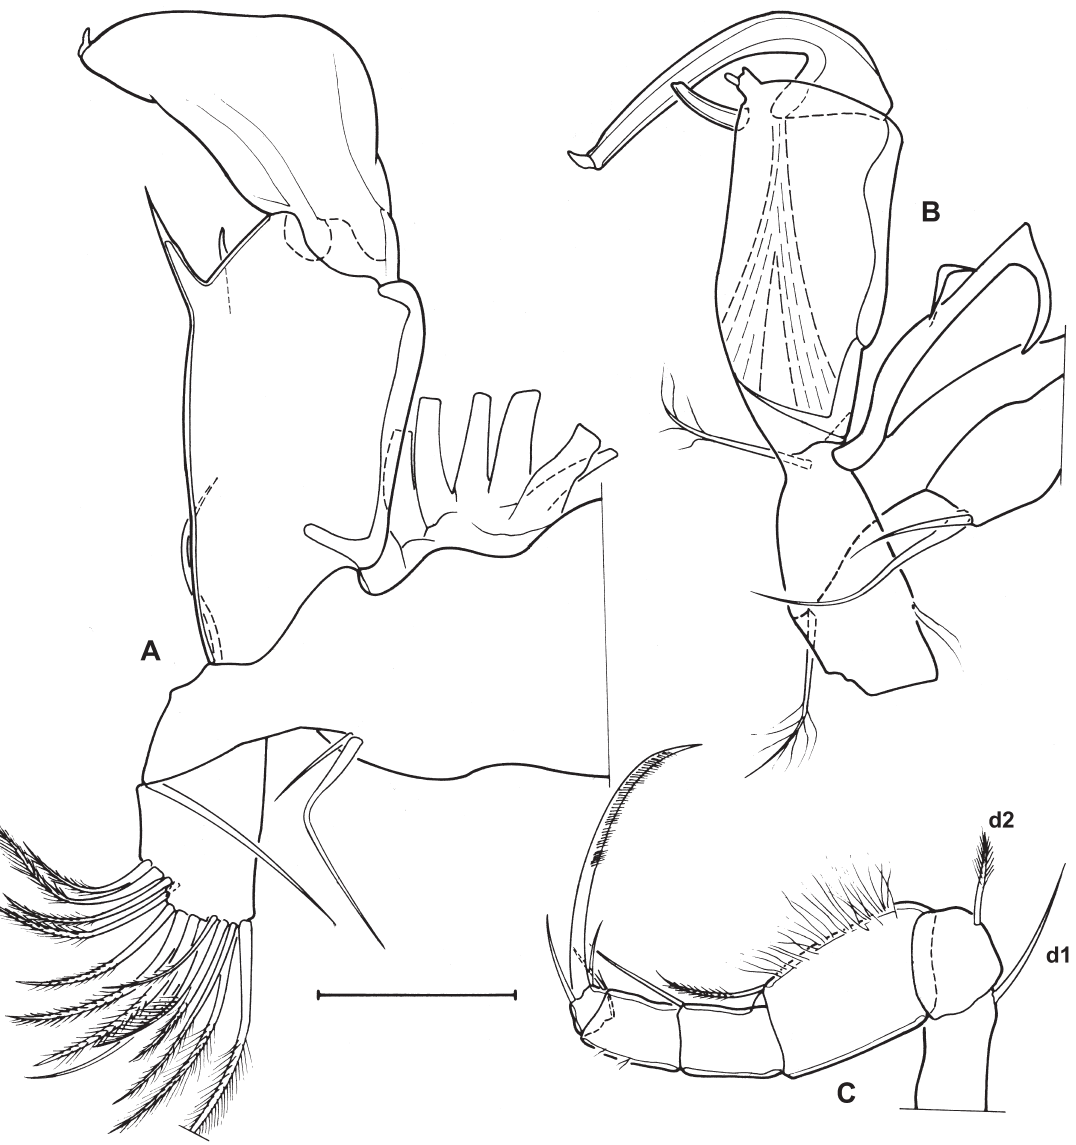
Fig. 13. Bennelongia coondinerensis sp. nov. ♂. A . T1, showing right prehensile palp (holotype ♂, WAM.C49389). B . Left prehensile palp (Idem). C . T2 (OC.3315). Scales: C = 232 µm; A,B = 92